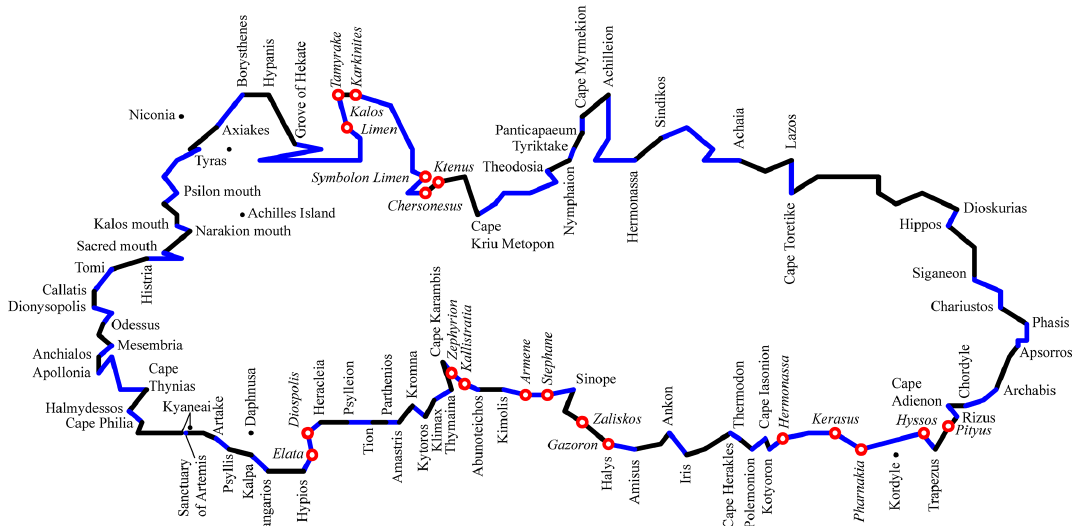
Figure 3. Ptolemy’s coastline of the Pontus divided into 74 short stretches between the points that have counterparts in Pseudo-Arrian’s Periplous . Points located in the wrong order are marked in red and displayed using italic